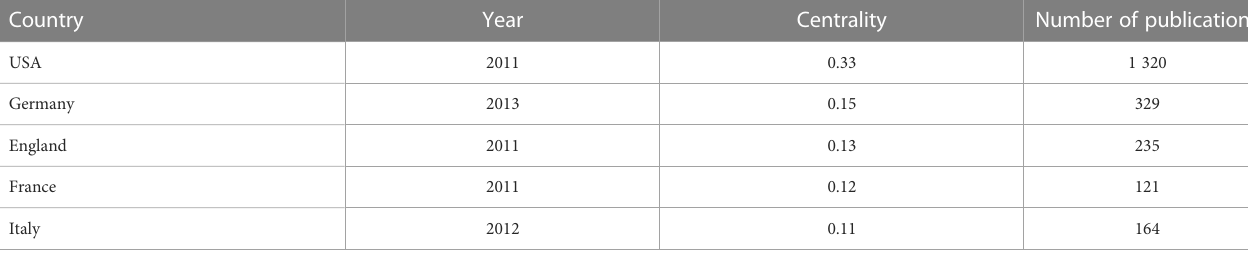
TABLE 2 Centrality rankings of the top fi ve nations ’ publications in the fi eld of tumor organoids.